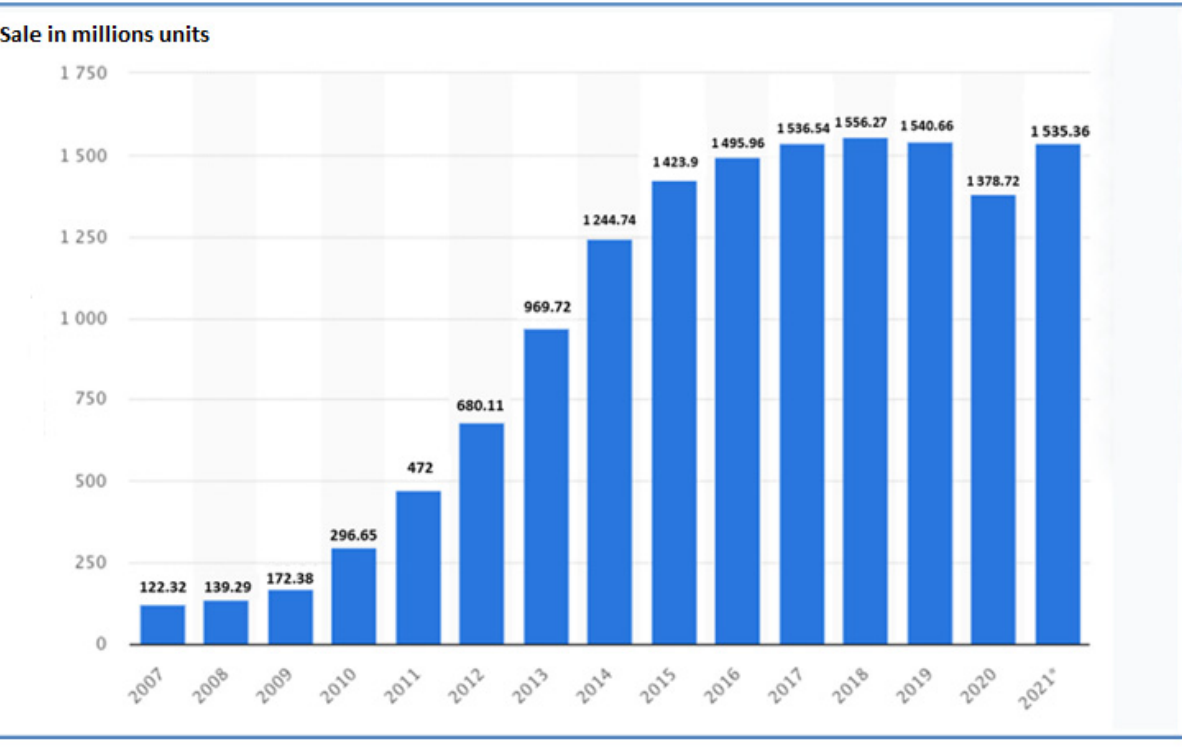
Figure 7. Source: Statista, Sales of smartphones saturated in 2017 then declined in 2020 (* forecast).